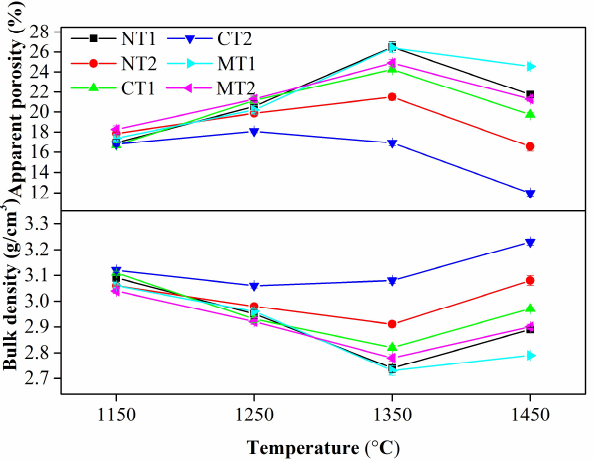
Figure 7. Apparent porosity and bulk density of samples after calcination at different temperatures.